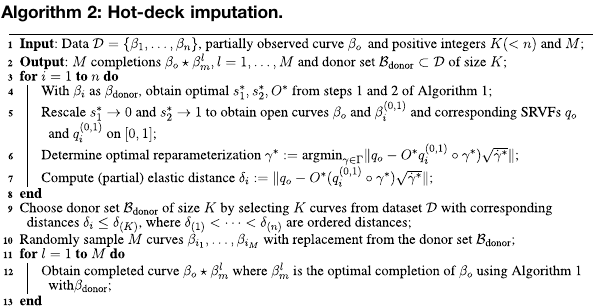
Algorithm 2 to the completion step 3 in Algorithm 1 : here,